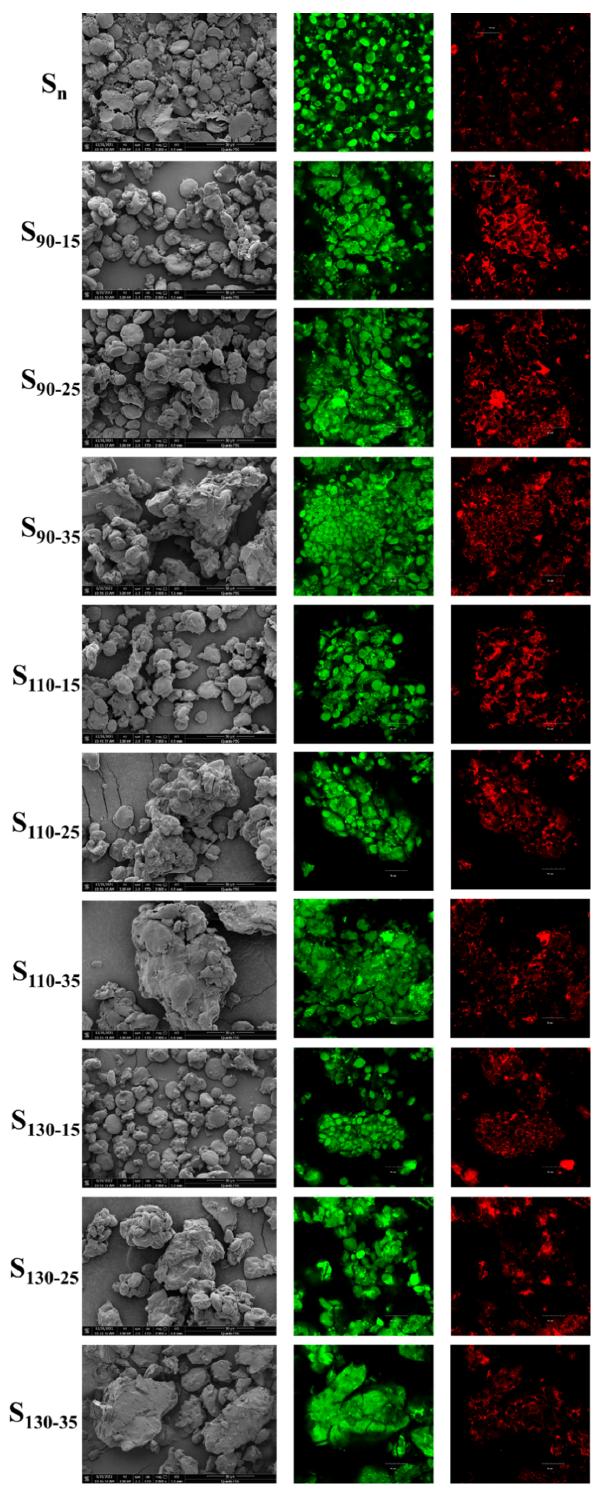
Figure 4. Morphological characteristics of native and HMT HB flours. S n indicates native HB flour; S 90 − 15 , S 90 − 25 , S 90 − 35 indicate that the heating temperature of HB flour is 90 ◦ C; S 110 − 15 , S 110 − 25 , S 110 − 35 indicate that the heating temperature of HB flour is 110 ◦ C; S 130 − 15 , S 130 − 25 , S 130 − 35 indicate that the heating temperature of HB flour is 130 ◦ C; S 90 − 15 , S 110 − 15 , S 130 − 15 indicate that the moisture content of HB flour is 15%; S 90 − 25 , S 110 − 25 , S 130 − 25 indicate that the moisture content of HB flour is 25%; S 90 − 35 , S 110 − 35 , S 130 − 35 indicate that the moisture content of HB flour is 35%. Starch stained by FITC emits green, protein stained by Rhodamine B emits